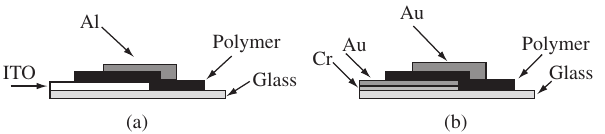
Figure 1. Schematic representations of the polymer structures used in this work. a) ITO/MH-PPV/Al and b) Au/MH-PPV/Au.